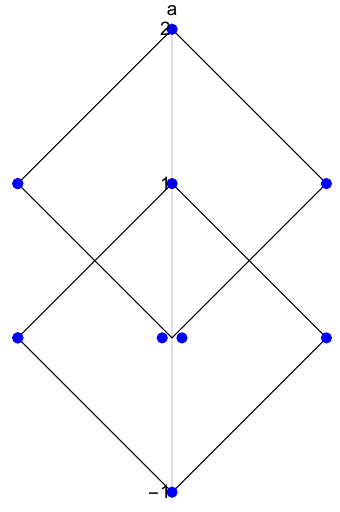
Figure 4 . Homological diagram for 6 1